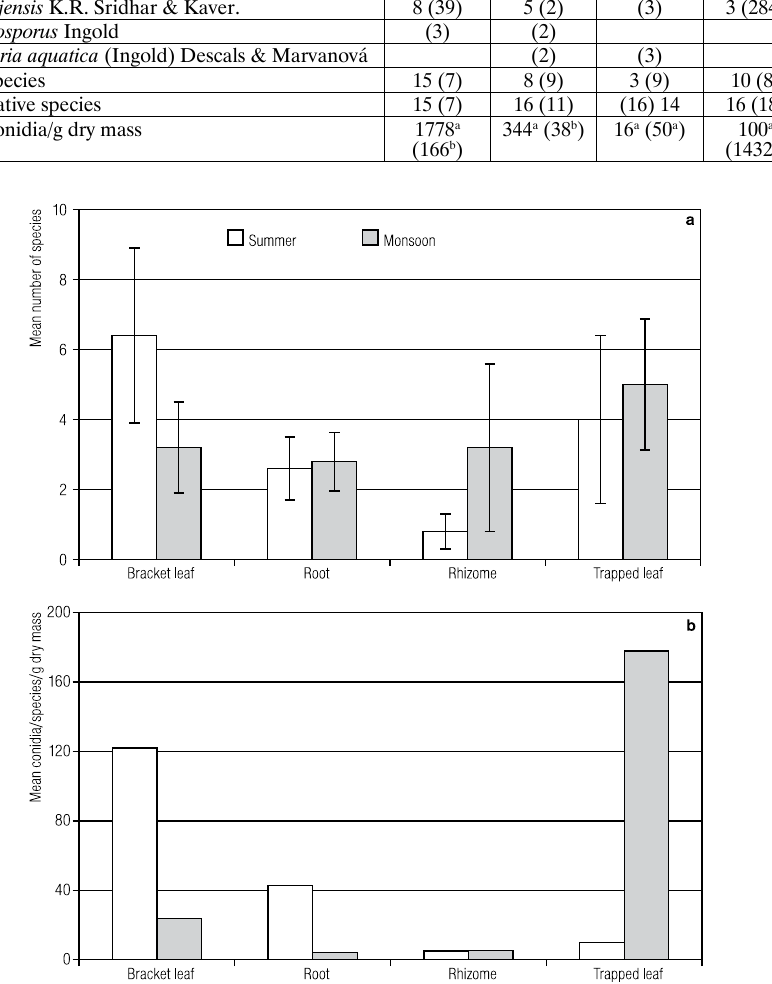
Fig. 1. Mean number of species (a) (n=5, mean ± SD) and mean conidia (n=5) per species per gram dry mass (b) of bracket leaf, root, rhizome ( Drynaria quercifolia ) and trapped leaf litter of Konaje